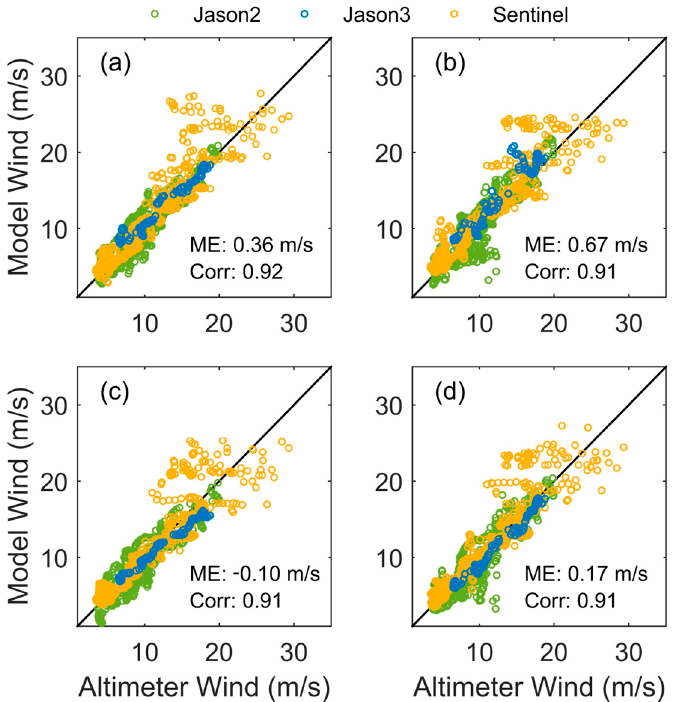
Figure 6. Typhoon Shanshan. Comparison of altimeter-observed 10 m winds with model results from experiments ( a ) R0, ( b ) R1, ( c ) R2, and ( d ) R3. See Table 1 for details of the different numerical experiments.